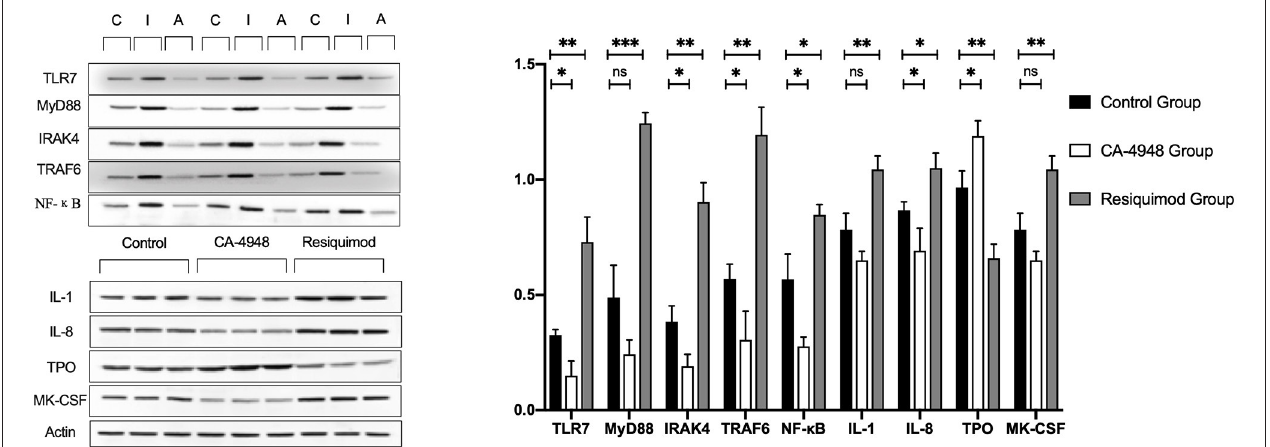
FIGURE 6 | Western blot of TLR pathway and platelet-related markers of the submandibular gland tissue of NOD mice. Submandibular gland was obtained at the age of 13 weeks, after intervention of CA-4948/Resiquimod/saline for 5 weeks. C: control group treated with saline; I: inhibitor group (treated with CA-4948); A: activator group (treated with Resiquimod). Compared with saline control group, Resiquimod induced significantly increased expression of the TLR7 signaling pathway molecules, interleukin (IL)-1 β , IL-8, and Megakaryocyte Colony Stimulating Factor (MK-CSF), and decreased expression of TPO in the submandibular glands. While CA-4948 group showed opposite expression trends of these molecules (* p < 0.05, ** p < 0.01, *** p < 0.001; ns, not